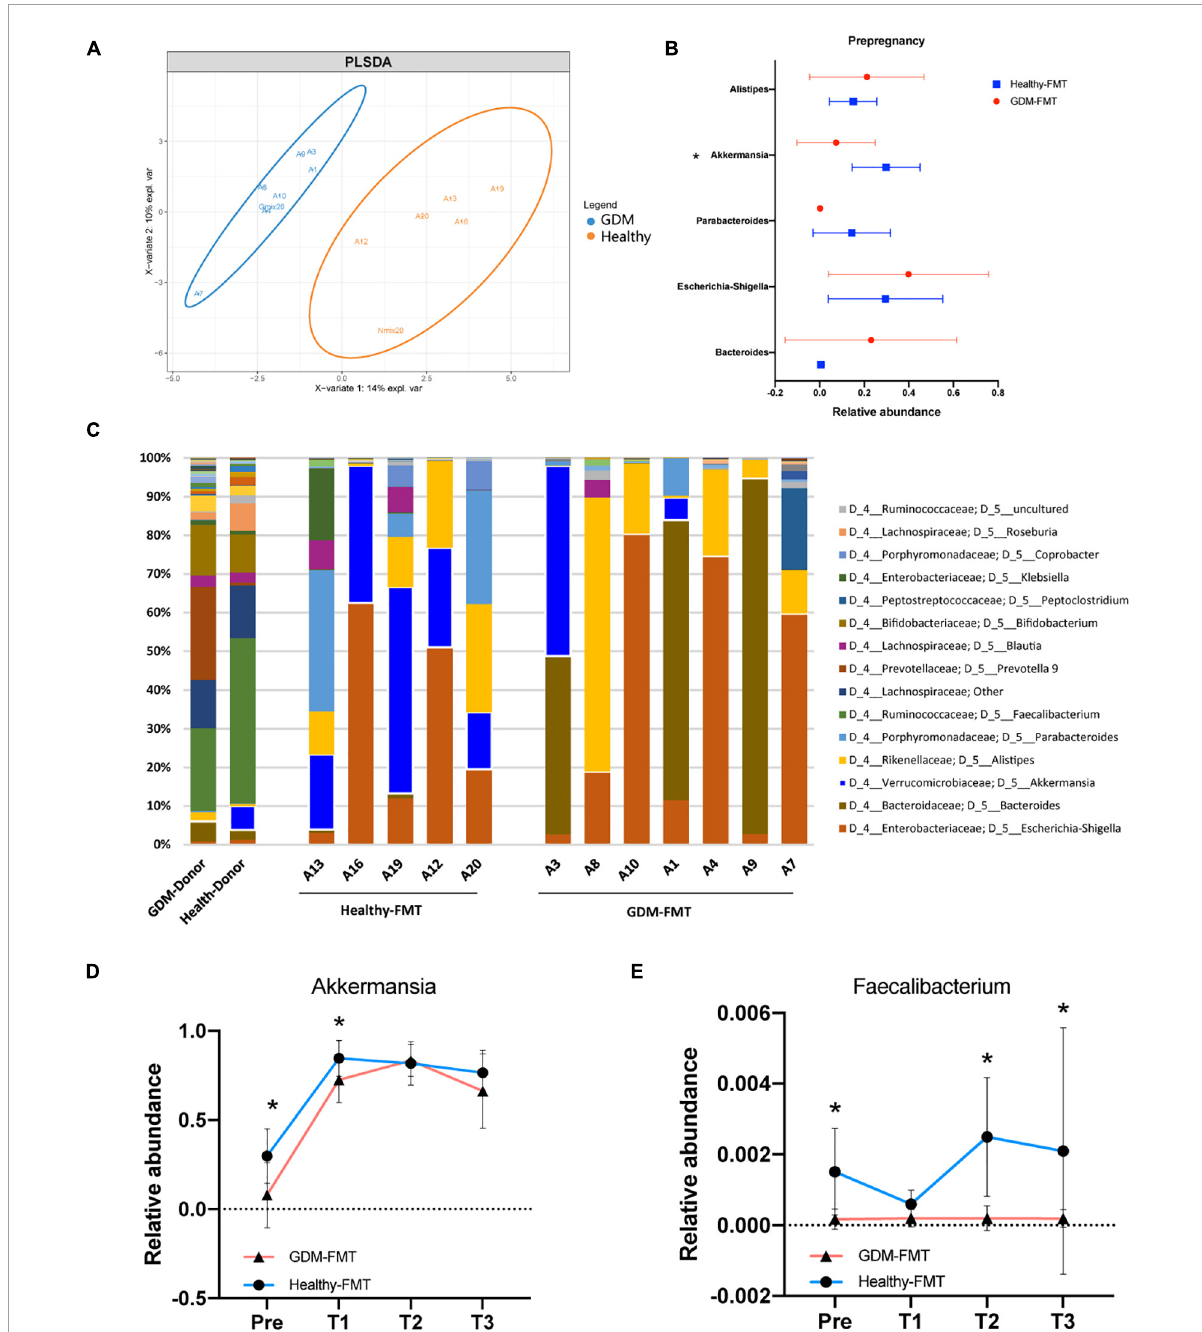
FIGURE2 Fecal microbiota transplantation affects the structure of the mouse gut microecology. (A) Orthogonal partial least-squares discriminant analysis at the genus level is shown along the first two variate axes. Individual samples are represented by blue (GDM-group) and red (healthy-group), and the two donor data are marked separately in the figure. (B) The bacterial relative abundance of bacteria at the genus level. (C) The bacterial relative abundance at the genus level after FMT. (D,E) The line graph shows the relative abundance of Akkermansia and Faecalibacterium bacteria between the two groups at different stages. Individual samples are represented by blue lines (healthy-FMT) and red lines (GDM-FMT). The data are shown as the median and interquartile range. * p <